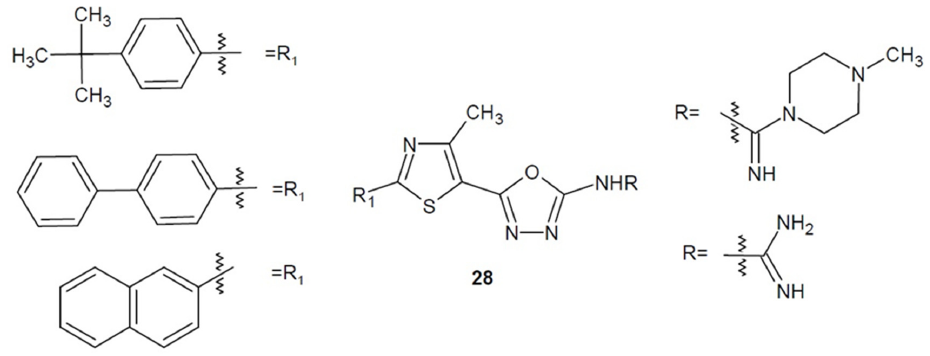
Figure 11. Amino-1,3,4-oxadiazole derivatives with antibacterial activity (part 3).